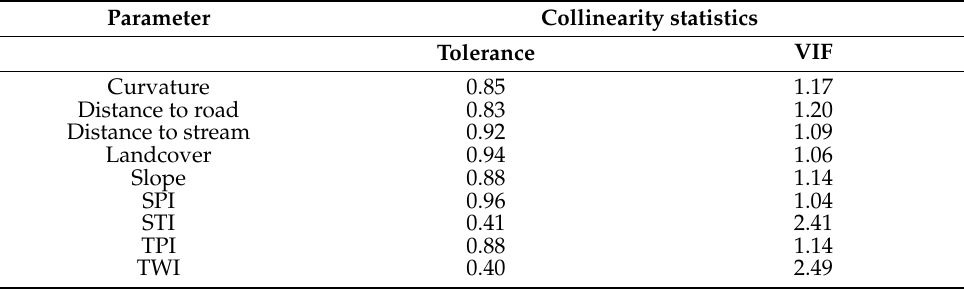
Table 1. Multicollinearity test statistics of gully conditioning factors.